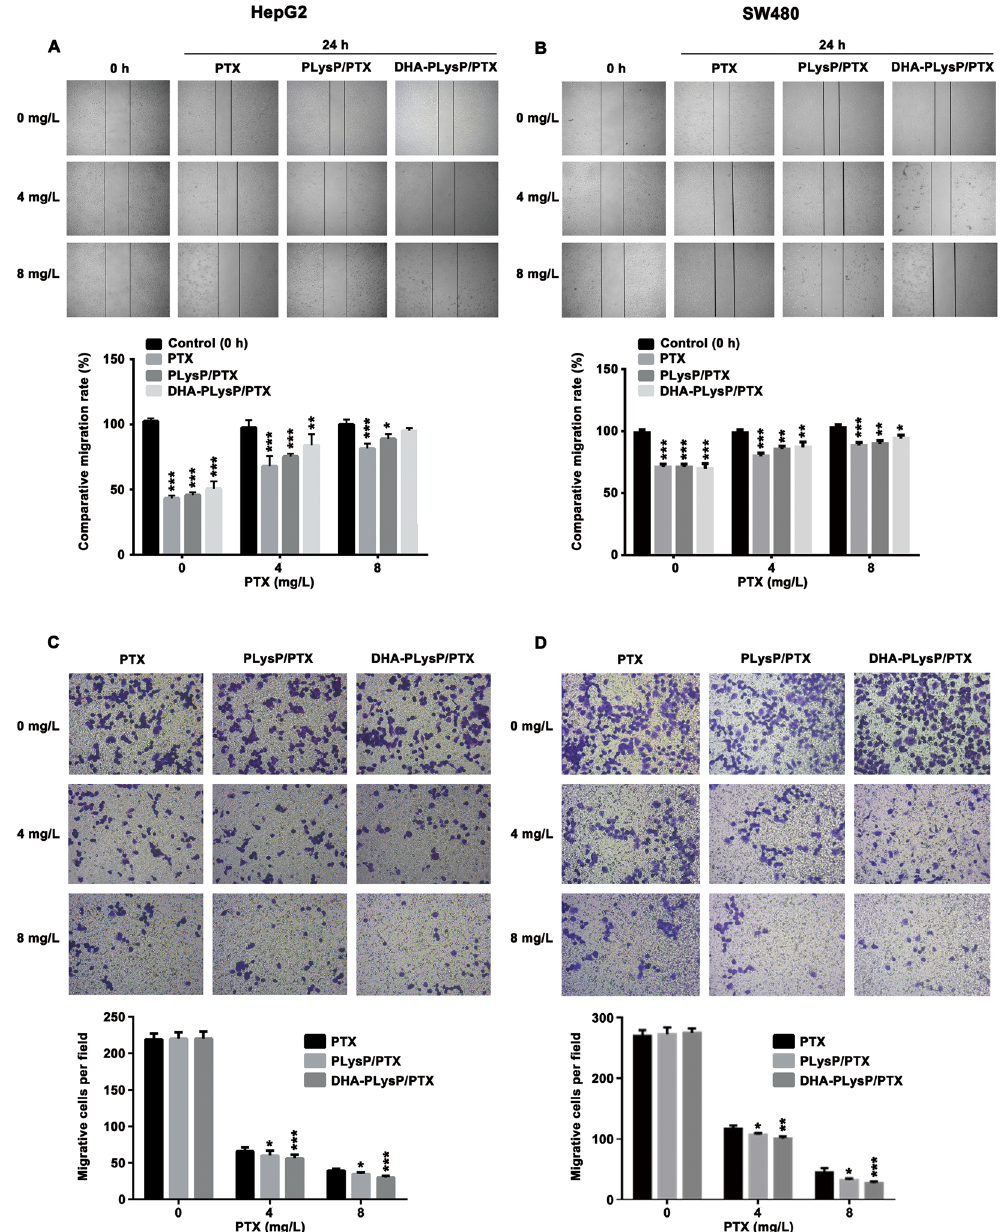
Figure 4. Migration inhibition of the HepG2 and SW480 cells under the treatment of free PTX, PLysP/ PTX and DHA-PLysP/PTX micelles with different dose of PTX. ( A,B ) Differential cell migration ability was examined by the wound-closure assay (magnification × 100). Densitometric analysis on wound closure speed is expressed as % of control. ( C,D ) Representative statistical chart for the transwell assay showed a significant decrease in migration by DHA-PLysP/PTX micelles, relative to control. * p < 0.05, ** p < 0.01, *** p <